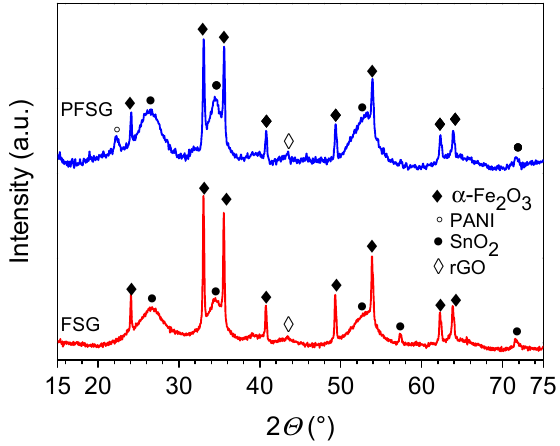
Figure 1. Di ff ractograms of the FSG and PFSG composites with an annotation of the phases attributed to each peak.